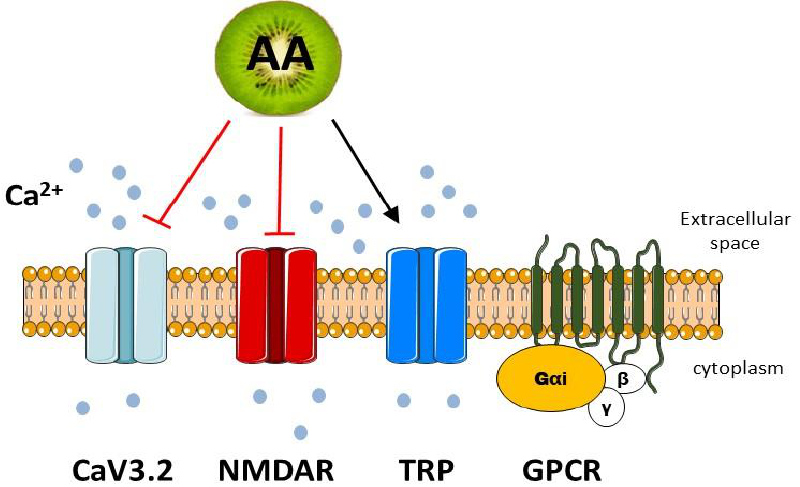
Figure 1. The regulation of Ca 2+ -permeable channels by vitamin C. CaV3.2—T-type voltage- dependent Ca 2+ channel; NMDAR—N-methyl-D-aspartate receptor; TRP—transient receptor potential channel; GPCR—G-protein-coupled receptor; AA—ascorbic acid (vitamin C). Red arrow—inhibition; black